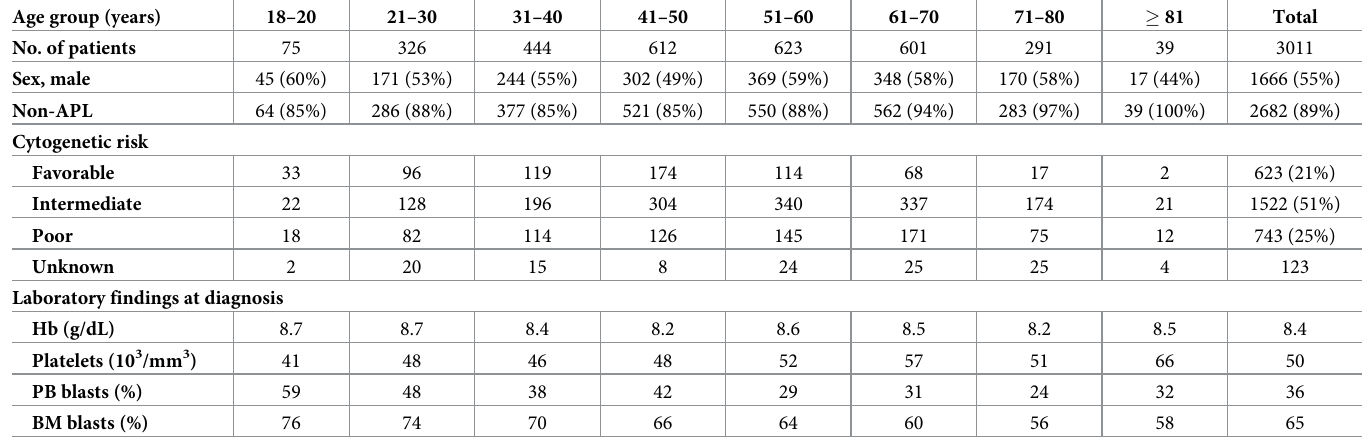
Table 1. Baseline